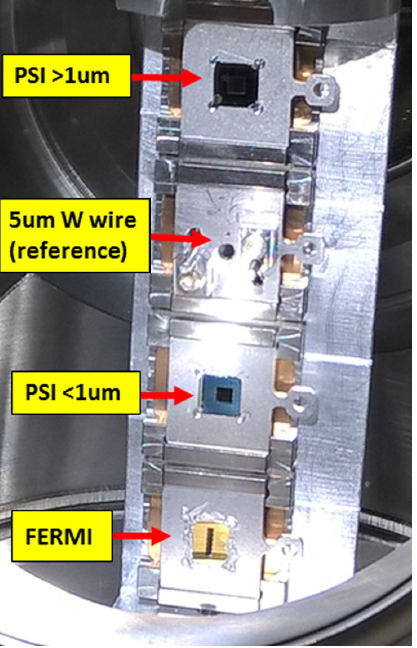
FIG. 5. Free-standing WS with submicrometer resolution in- stalled in the sample holder. From top to bottom: PSI chip equipped with 2 Au stripes with a width of 2 and 1 μ m (PSI > 1 μ m); PSI chip equipped with a standard cylindrical W wire with a diameter of 5 μ m (5um-W-wire); PSI chip equipped with 2 Au stripes with a width of 1 and 0 . 9 μ m (PSI < 1 μ m); FERMI chip equipped with 6 Au stripes width ranging from 2.5 to 0 . 7 μ m (FERMI). As described in the present work, the electron-beam characterization at SwissFEL mainly focused on the free-standing WS with the best geometric resolution, i.e., the PSI 0 . 9 μ m and FERMI 0 . 8 μ m wide